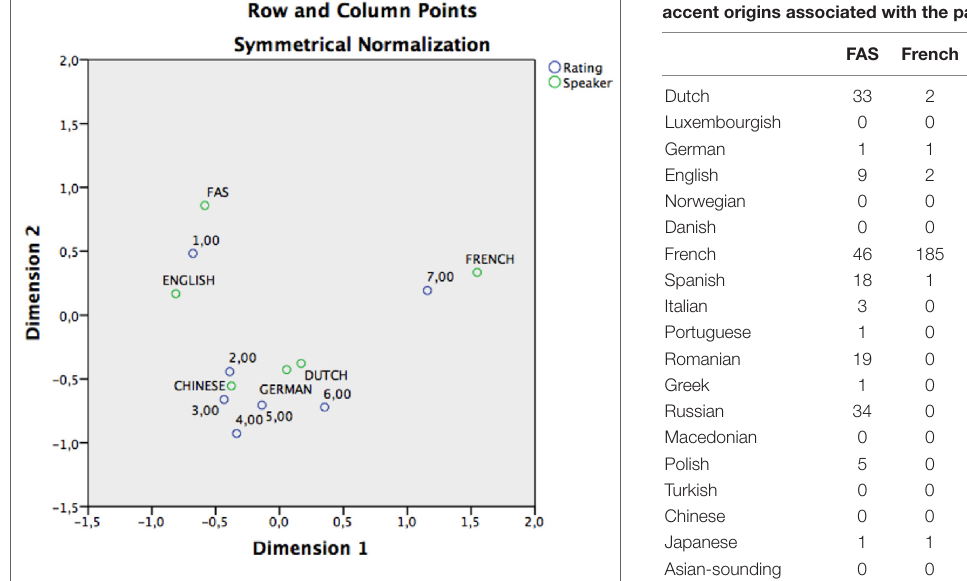
FIGURe 1 | perceptual accent rating experiment: correspondence analysis graphically displaying the accent dispersion and associated accent ratings in a two-dimensional space . The points represent a vector transformation of the data displayed in table 8 . The blue circles represent the accent rating and the green circles represent the speakers. Ratings were defined as column points, speakers as row points. The distances between the scores and speakers represent the strength of association between both values. Both FAS and English are more closely associated with “Definitely non-native speakers of French” ( = rating 1). French is (correctly) associated with “definitely a native speaker of French” ( = rating 7).